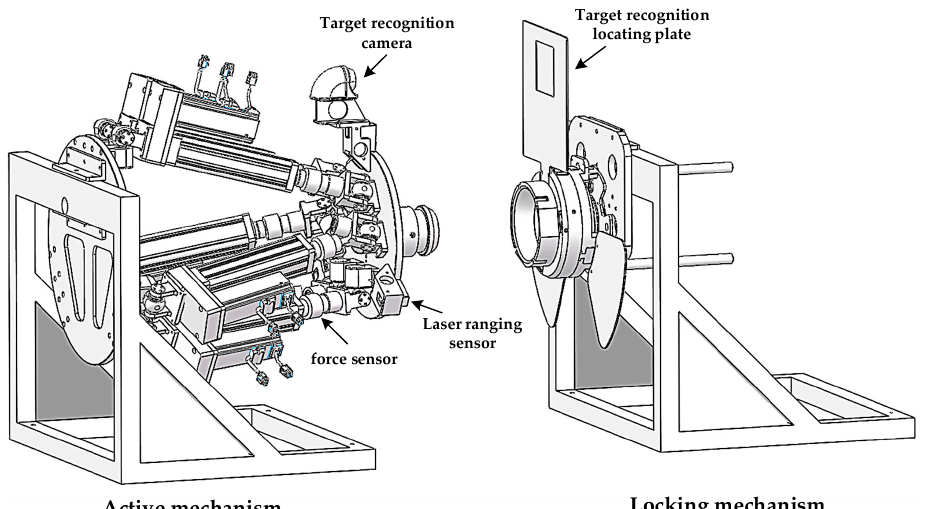
Figure 10. Hardware distribution diagram of docking mechanism. Table 1. 6-DOF platform parameter table.